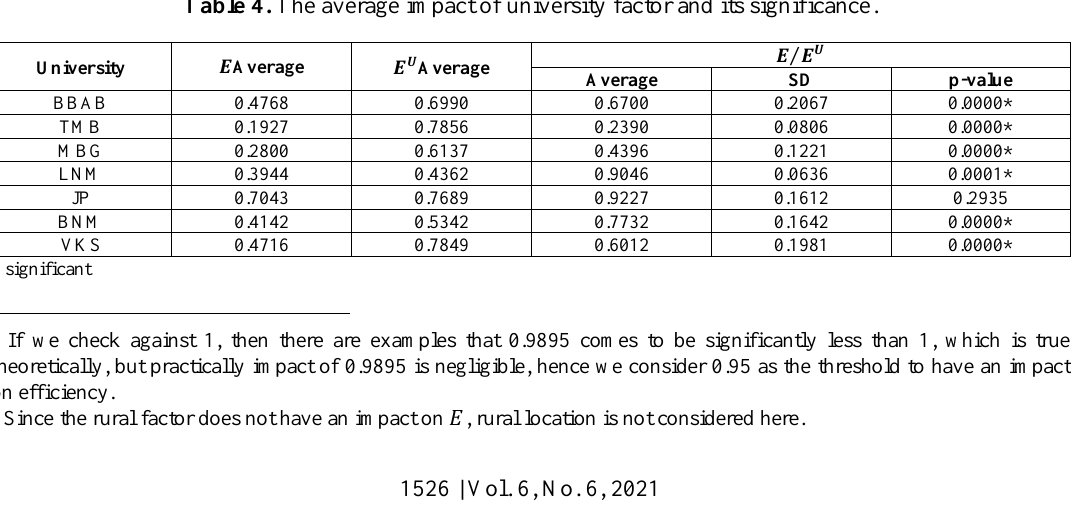
Table 4. The average impact of university factor and its